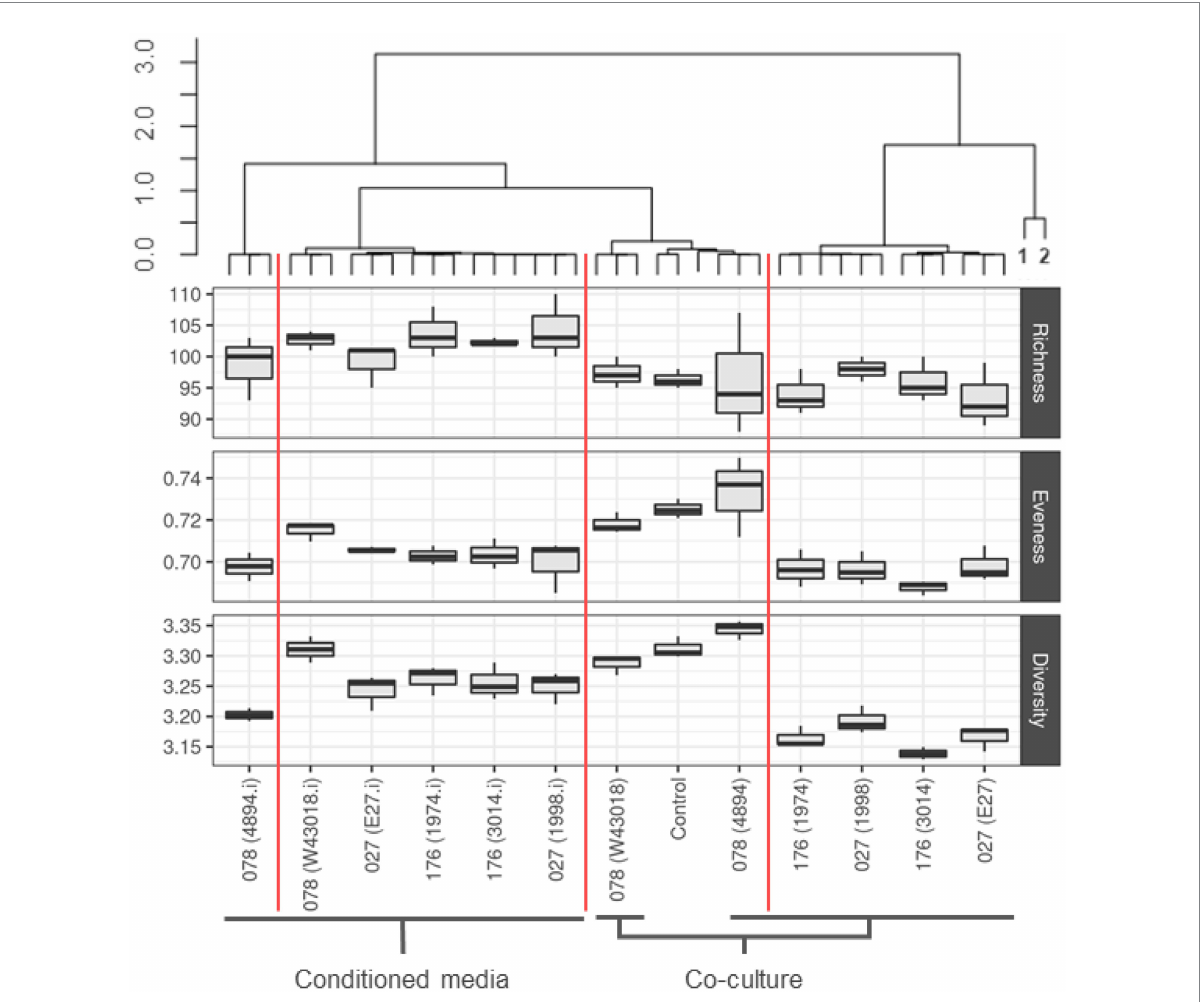
FIGURE 2 Community composition and alpha diversity of children microbiota after exposure to C. difficile culture or conditioned media. Clustering was performed on community compositions using correlation distances and ward. D clustering (R, pvclust package). Red vertical lines separate clusters based on 95% CI. Alpha indexes are presented with boxplots for each C. difficile strain, separately for co-cultures and conditioned media. We used number of unique OTUs for richness estimation, Shannon eveness for eveness estimation and Shannon for community diversity. Sampes 1 and 2 represent original fecal sample and over-night fecal culture,